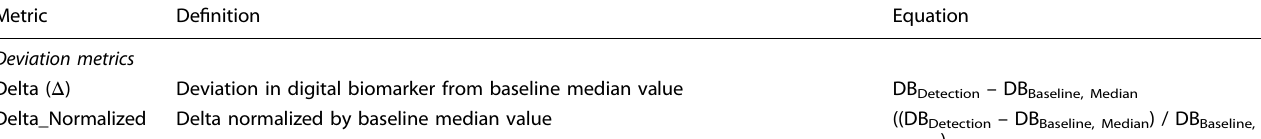
Table 2. Features extracted from the digital biomarkers (DBs) for the development of ITA algorithm.